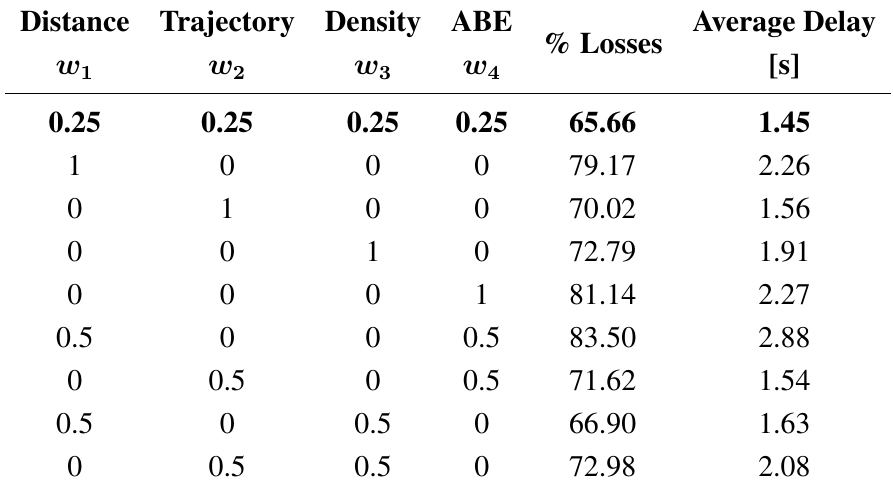
Table 5. A summary of the results of the evaluation of some combination of the weights for each metric (in a low density scenario). ABE, available bandwidth estimator.